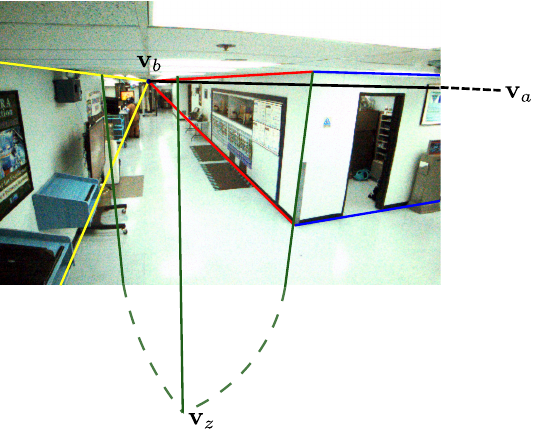
Figure 2. Vanishing Lines and Points: v a and v b are the vanishing points in the horizontal direction. v z is the vanishing